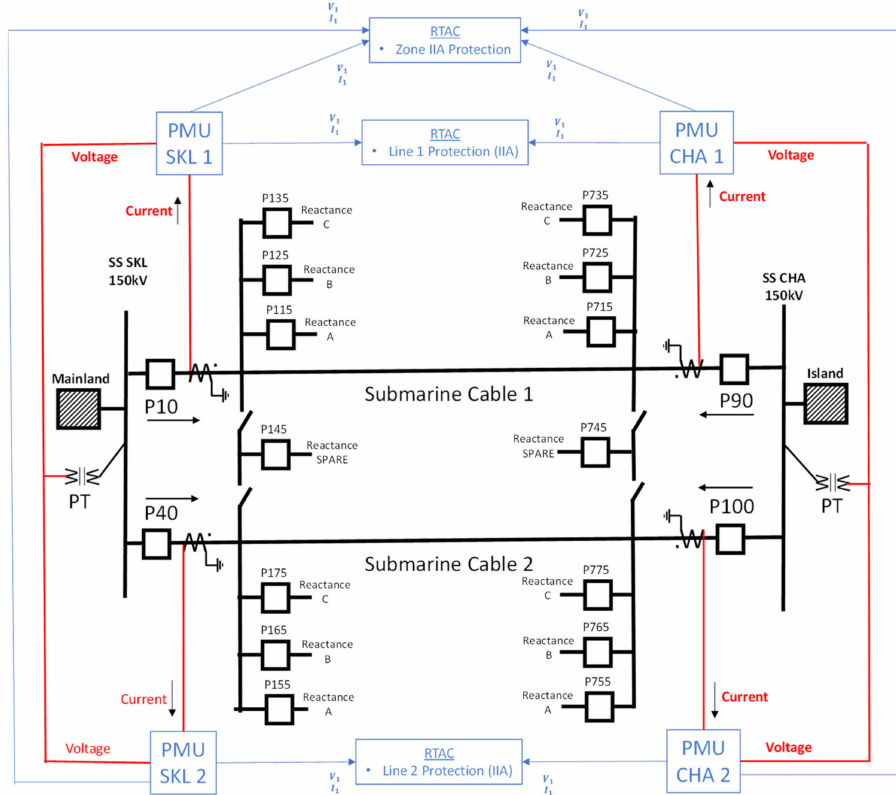
Figure 15. Submarine transmission grid for